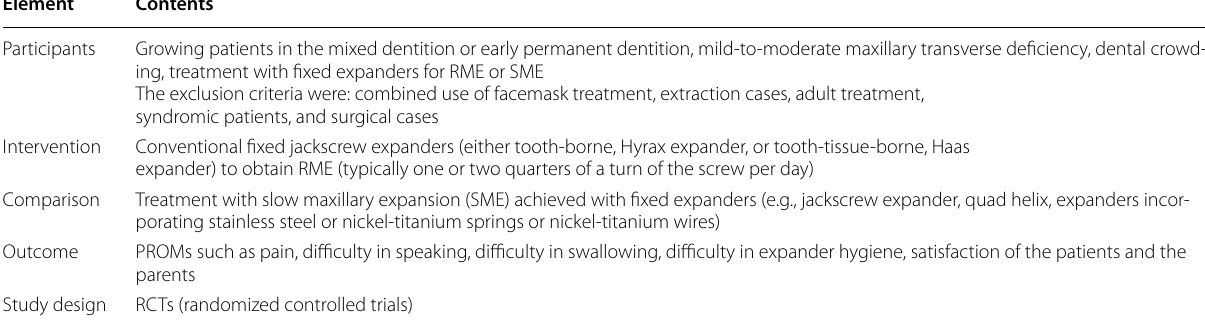
Table 1 Inclusion and exclusion criteria used for study selection (PICOS)